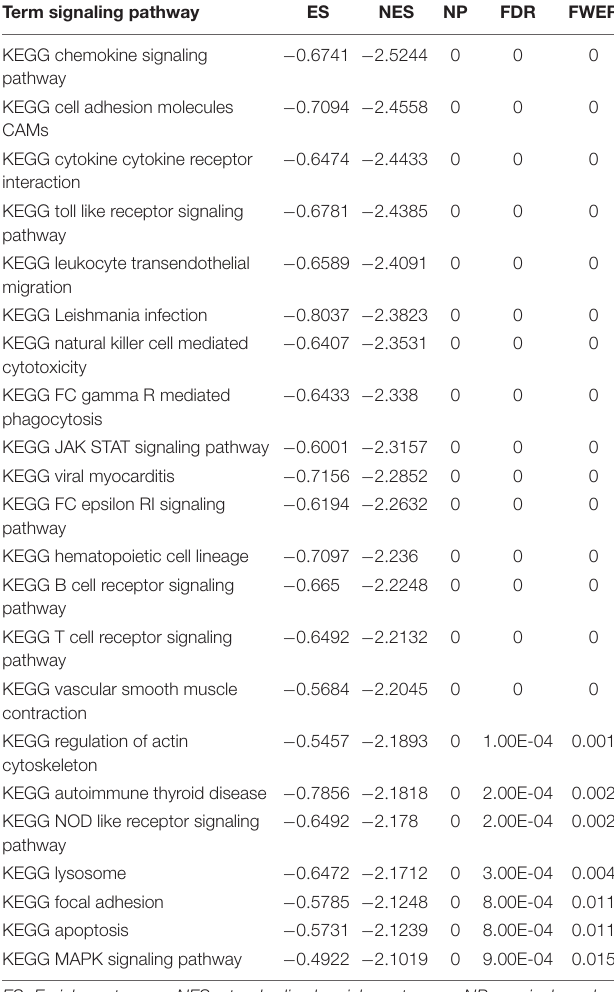
TABLE 2 | The expression of TLR4 gene in tumor was analyzed by GSEA. Term signaling